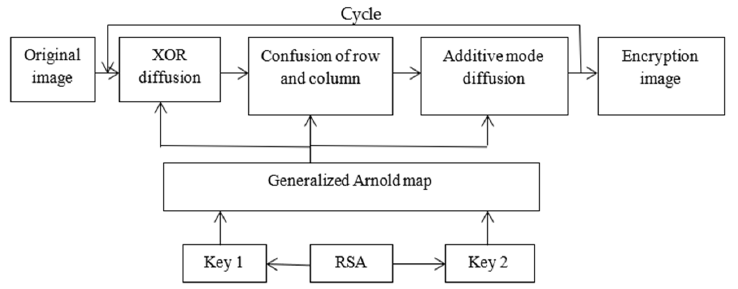
Figure 2. The image encryption algorithm.